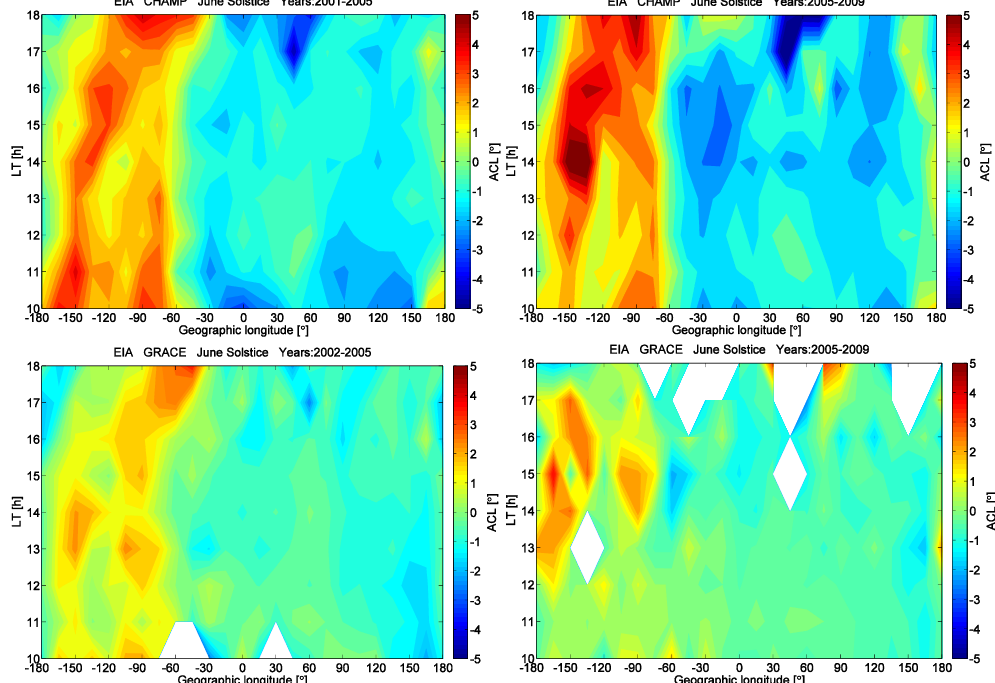
Fig. 4. The local time versus longitudinal distribution of the EIA inter-hemispheric asymmetry parameter ACL around June solstice months from CHAMP (top) and GRACE (bottom) observations during higher (left) and lower (right) solar activity years.